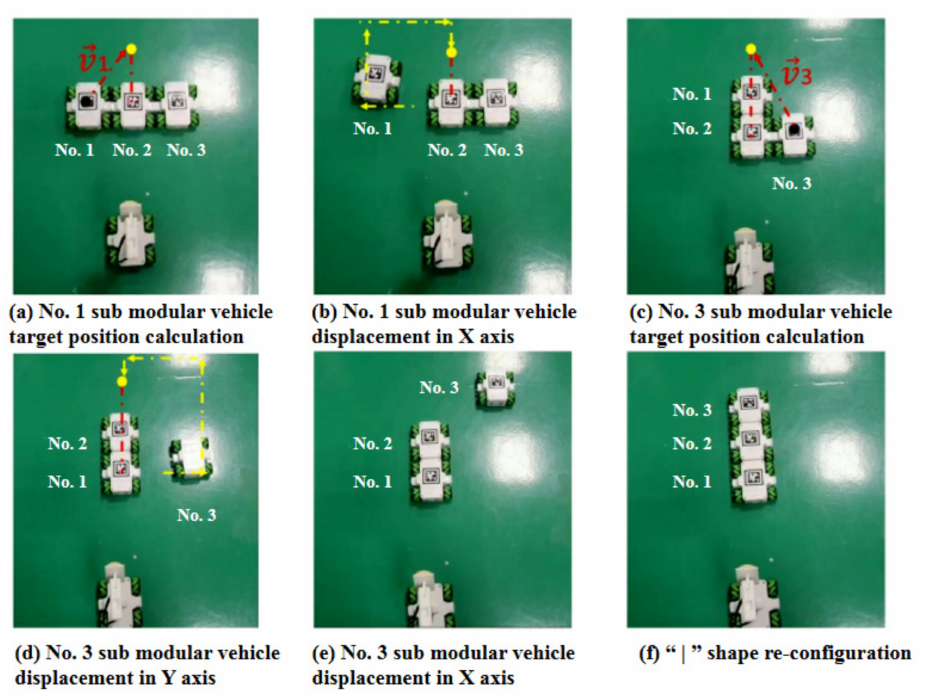
Figure 24. “ | ” shape reconfiguration procedure.